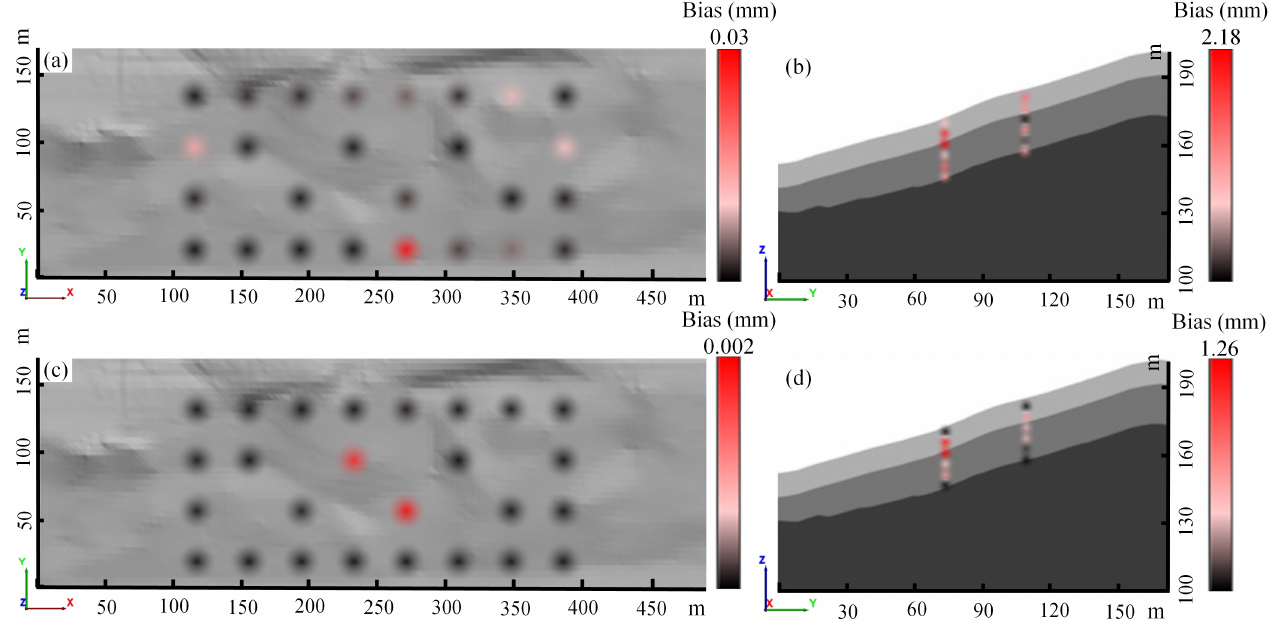
Figure 8. The bias in the GWR model: deviations for the ground and underground stations, respec- tively, corresponding to strategy 1 ( a , b ) and ( c , d ) strategy 2.